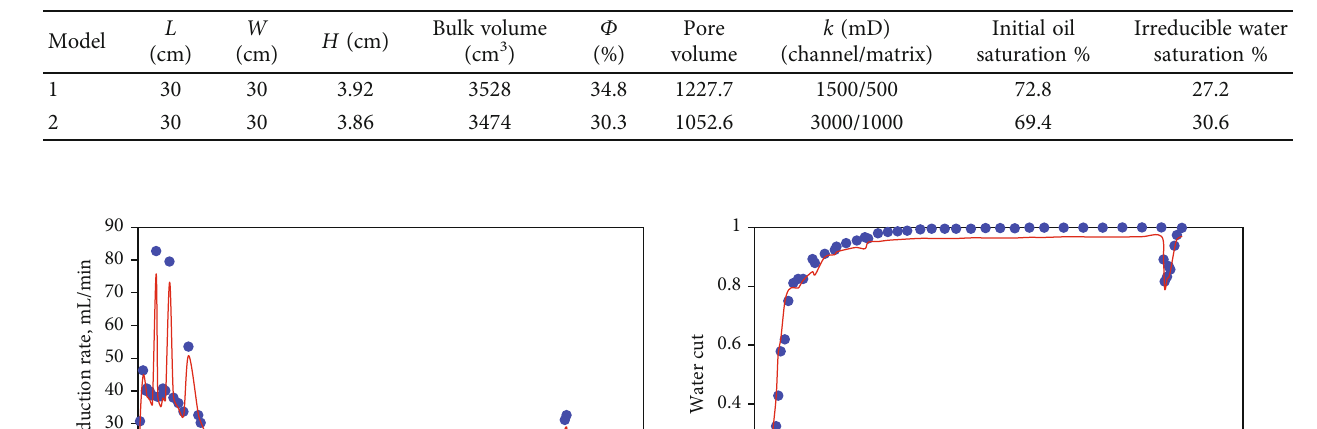
Table 1: Experimental